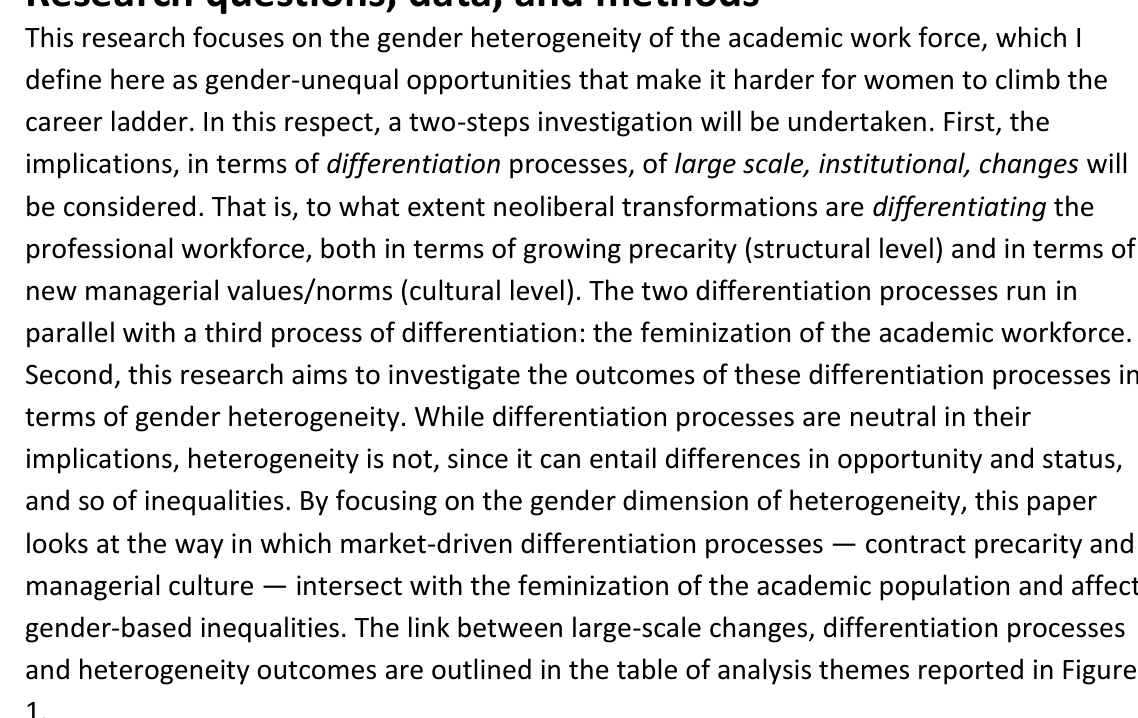
Figure 1. Table of analysis